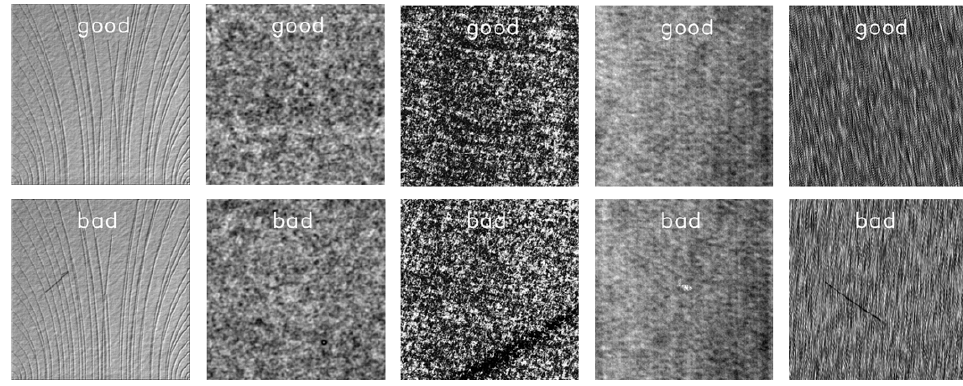
Figure 5. The surface defect detection result of our model.